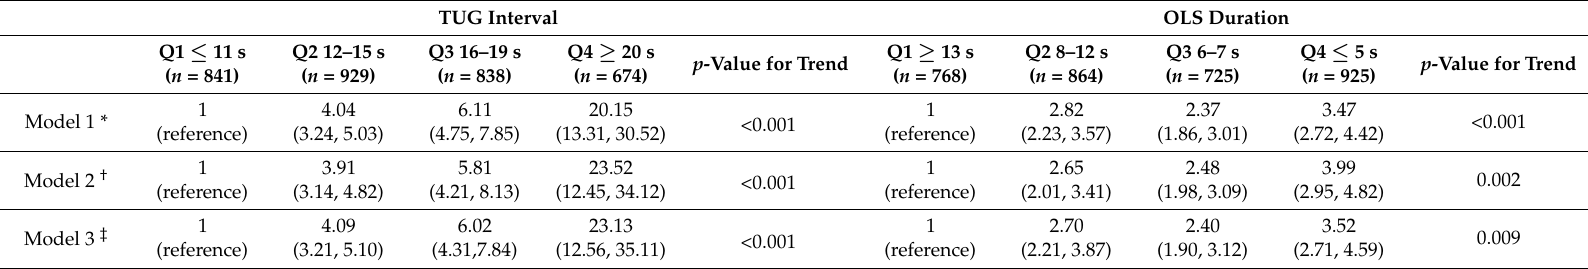
Table 6. The effect of lower limb function on the risk of cognitive disorder according to quartiles of TUG interval and OLS duration ( n =